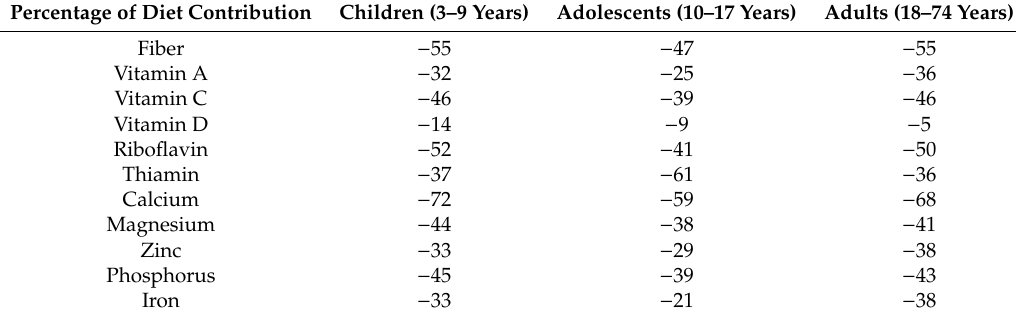
Table 5. Intake change (expressed as percentage of diet contribution) of some micronutrients and fiber after FODMAP risky food subtraction from the